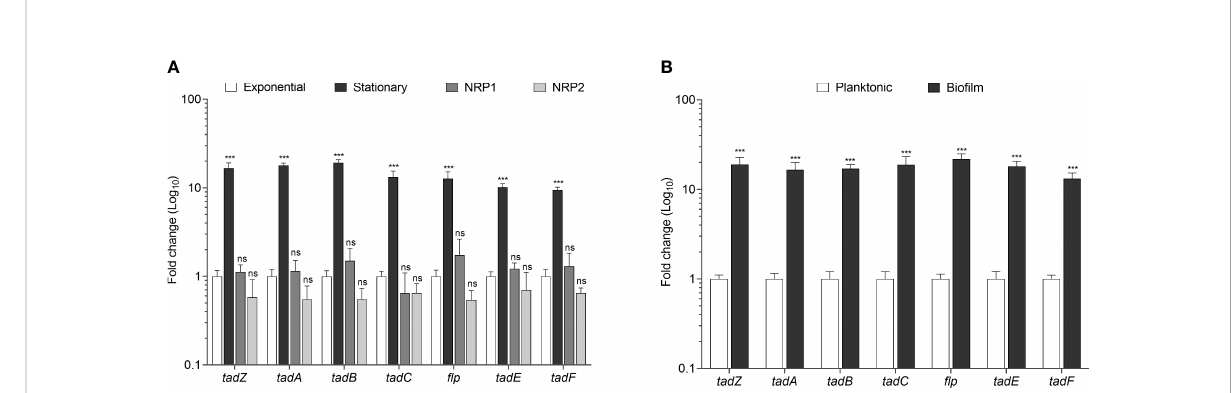
FIGURE 3 Transcriptional expression of tad/ fl p genes in Mtb growing at different growth phases. Fold change expression determined in Mtb growing at exponential, stationary, NRP1 and NRP2 phases (A) and during planktonic culture and bio fi lm formation (B) . Statistically signi fi cant relative to exponential phase (A) to planktonic culture (B) : *** p <0.001, ns: not signi fi